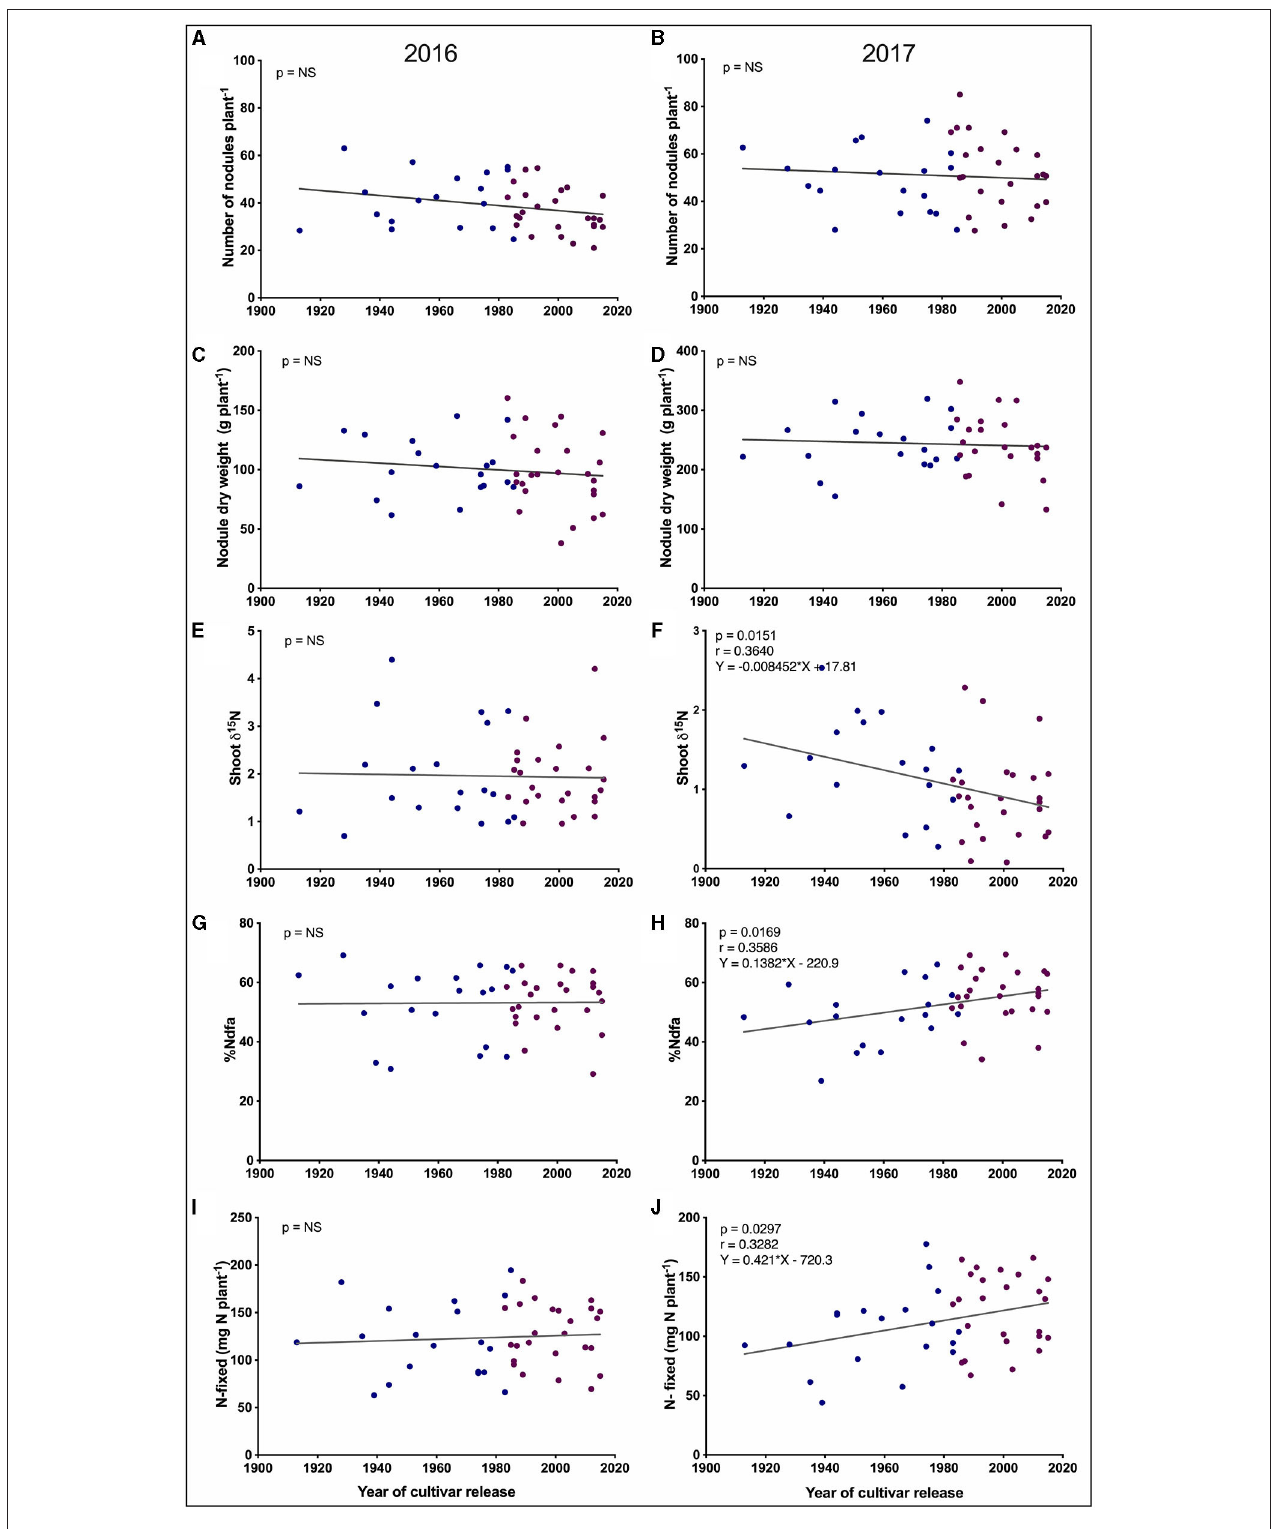
FIGURE 3 | Trait by year of cultivar release regression plots for pre-pod-fill SNF-related traits. (A,B) Number of nodules per plant. (C,D) Nodule dry weight per plant. (E,F) Shoot δ 15 N. (G,H) Percentage nitrogen derived from the atmosphere (%Ndfa). (I,J) Shoot nitrogen fixed per plant. Each blue and purple dot represents a historical and modern-Guelph cultivar, respectively. %Ndfa and N-fixed represent the vegetative shoot values. NS, not significantly different at p < 0.05.